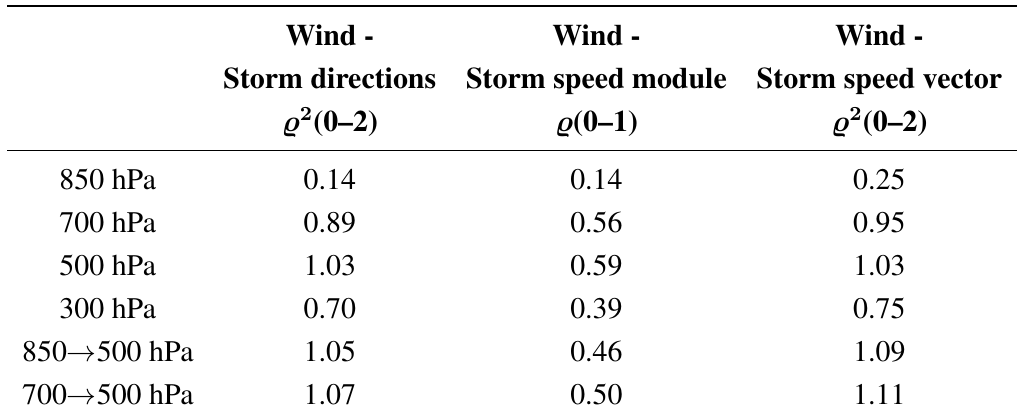
Table 3. Values of the correlation coefficient for the daily mean values. Vector correlation introduced by Crosby et al. [25] for storm directions and speed vector is used. Pearson correlation for storm speed module is instead